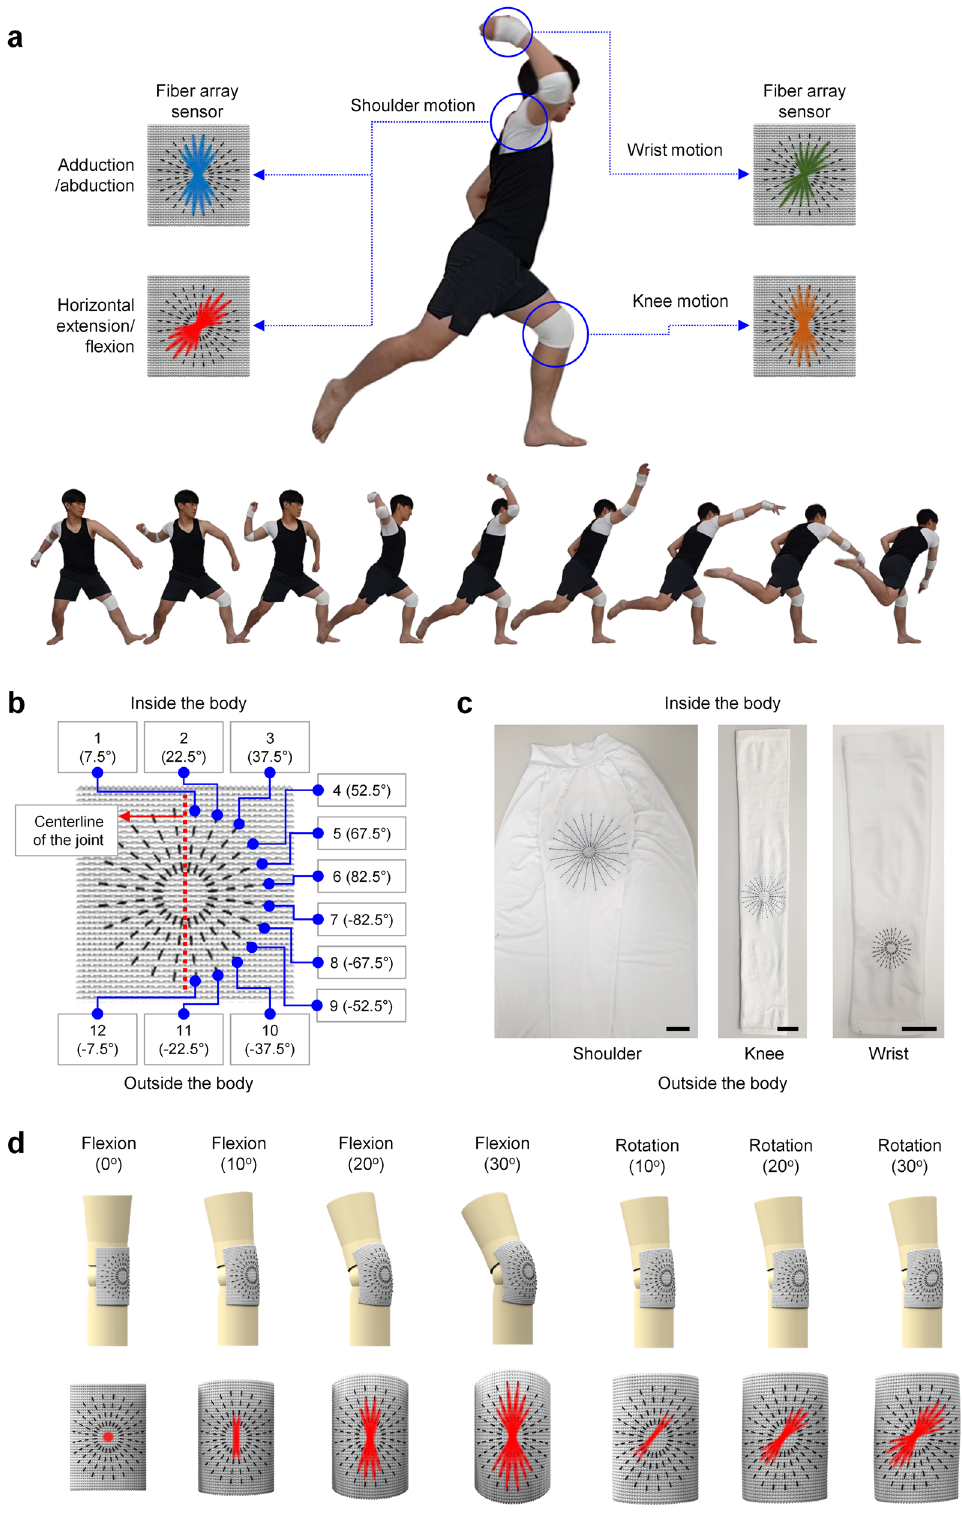
Fig. 1 Multi-angle fi ber arrayed fabric sensor for fl exion and rotation measurement in human joints. a The wearable joint motion monitoring fabric-based multi-angle fi ber array sensor worn on the shoulder, knee, and wrist. The types of motion detected at each joint are also depicted. b Schematic representation of 12 CNT-embedded spandex fi bers arranged radially at 15° intervals on the strain-sensing fabric. c Fiber arrayed fabric sensors in the warmers that were used to monitor shoulder, knee, and wrist movement. Scale bars: 40 mm. d Joint motion at various angles was read by recording the resistance change of the multi-angle fi ber array comprising 12 radially arranged sensors. The multi-angle fi ber array mapping response differs in fl exion and rotation. I, M. Son, consent to the use of my picture in connection with the